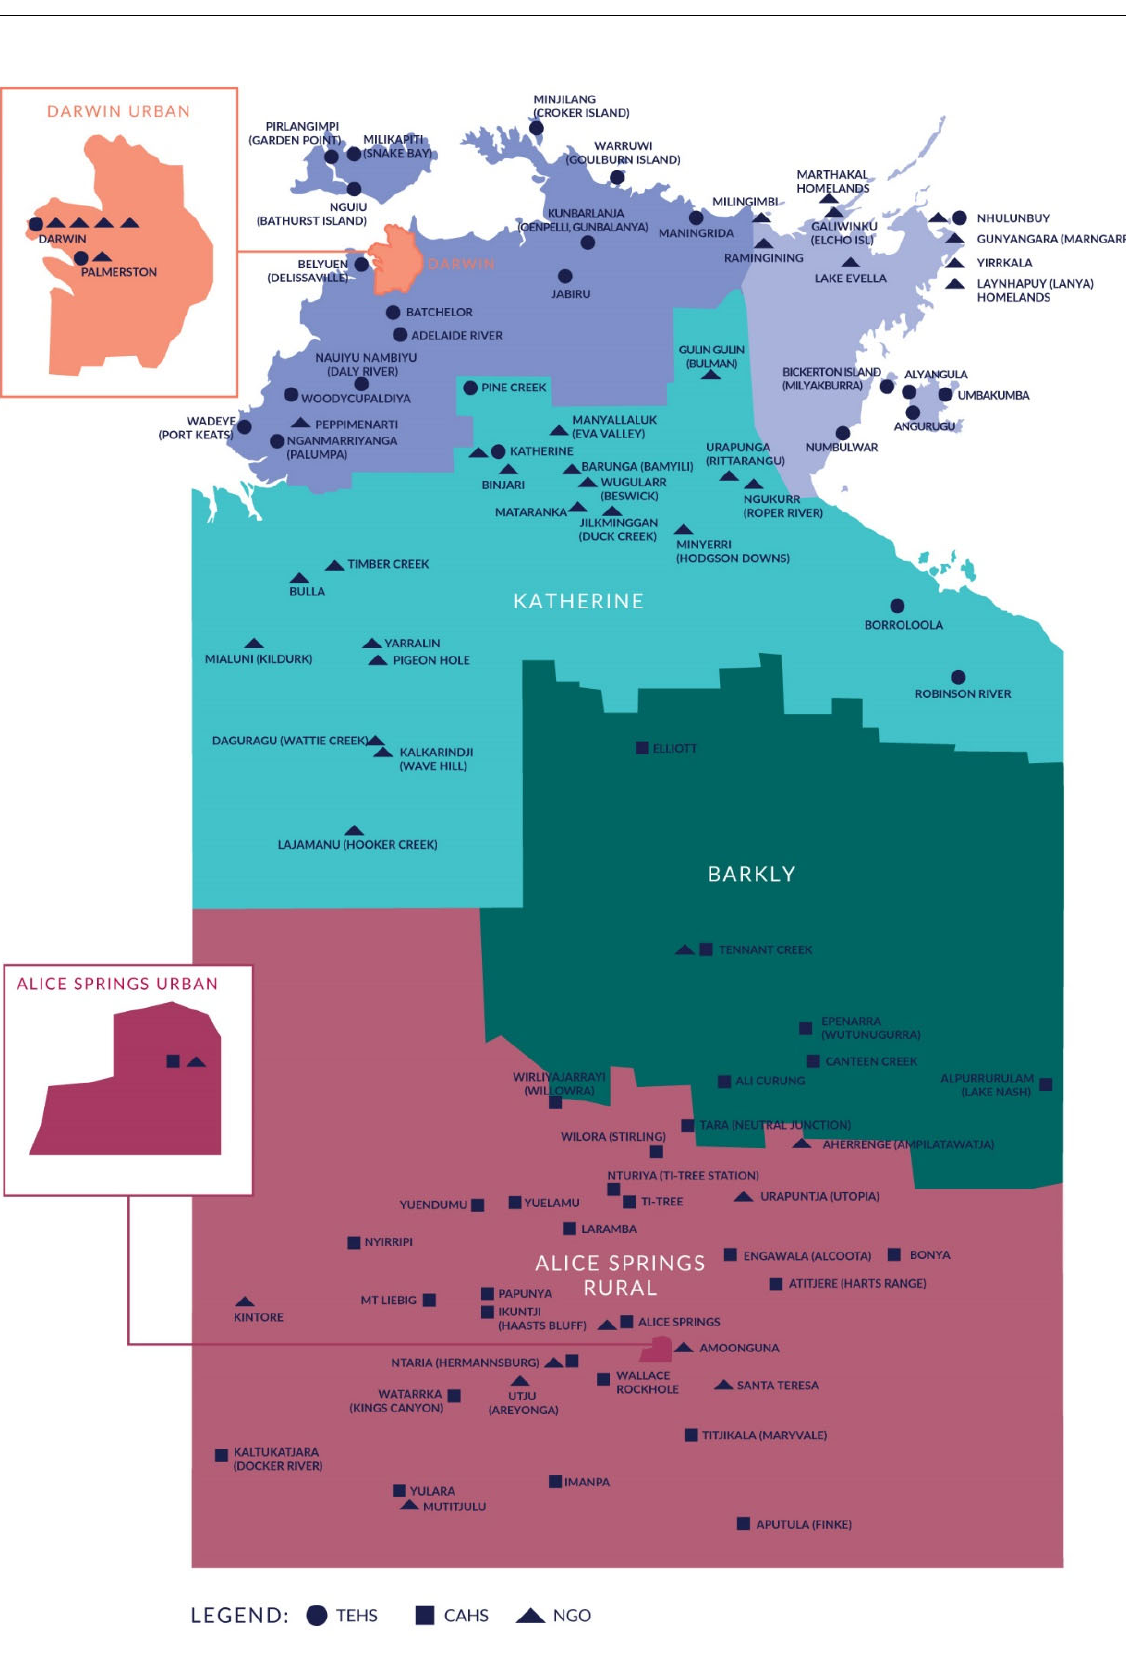
Figure 1. Top End and Central Australia Health Service locations [25]. TEHS = Top End Health Service; CAHS = Central Australian Health Service; NGO = Non-Government Organisation.